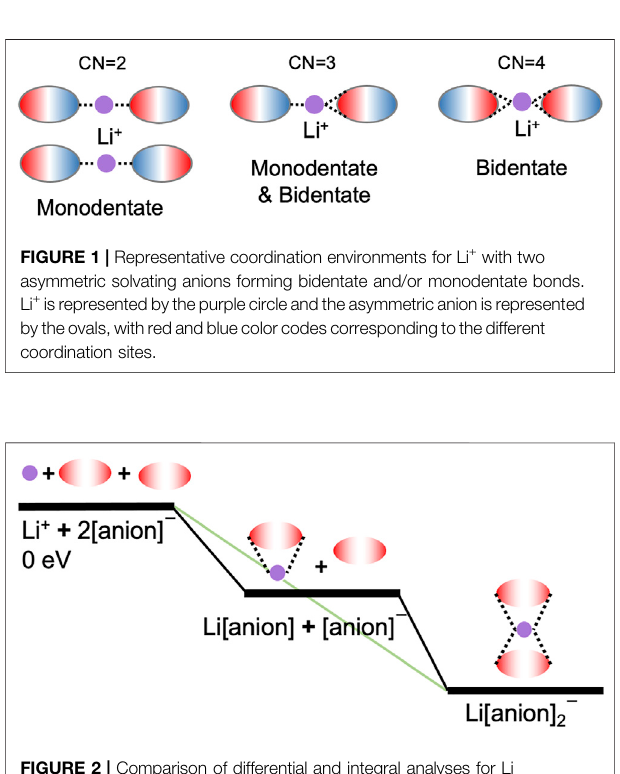
Frontiers in Energy Research |